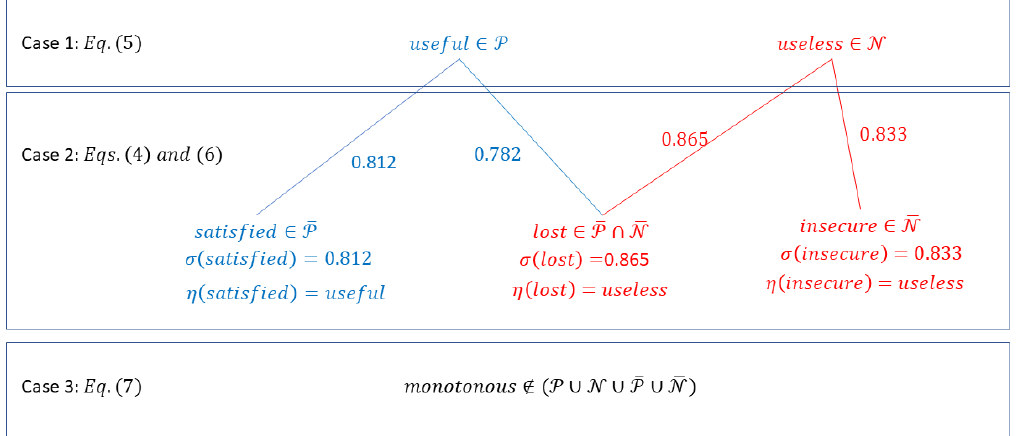
Figure 2. Part of the graph G showing only two of the nearest neighbours of útil (useful) and inútil (useless) . The words satisfecha (satisfied) and perdida (lost) are two of the nearest neighbours of útil (useful) . On the other hand, the words perdida (lost) and insegura (insecure) are two of the nearest neighbours of inútil (useless) . The similarities between pairs of neighbours are shown along the respective edges. At the bottom of the Figure, we show the word monotono (monotonous) that does not belong to either P ∪ N or P ∪ N , and therefore is not a vertex of G